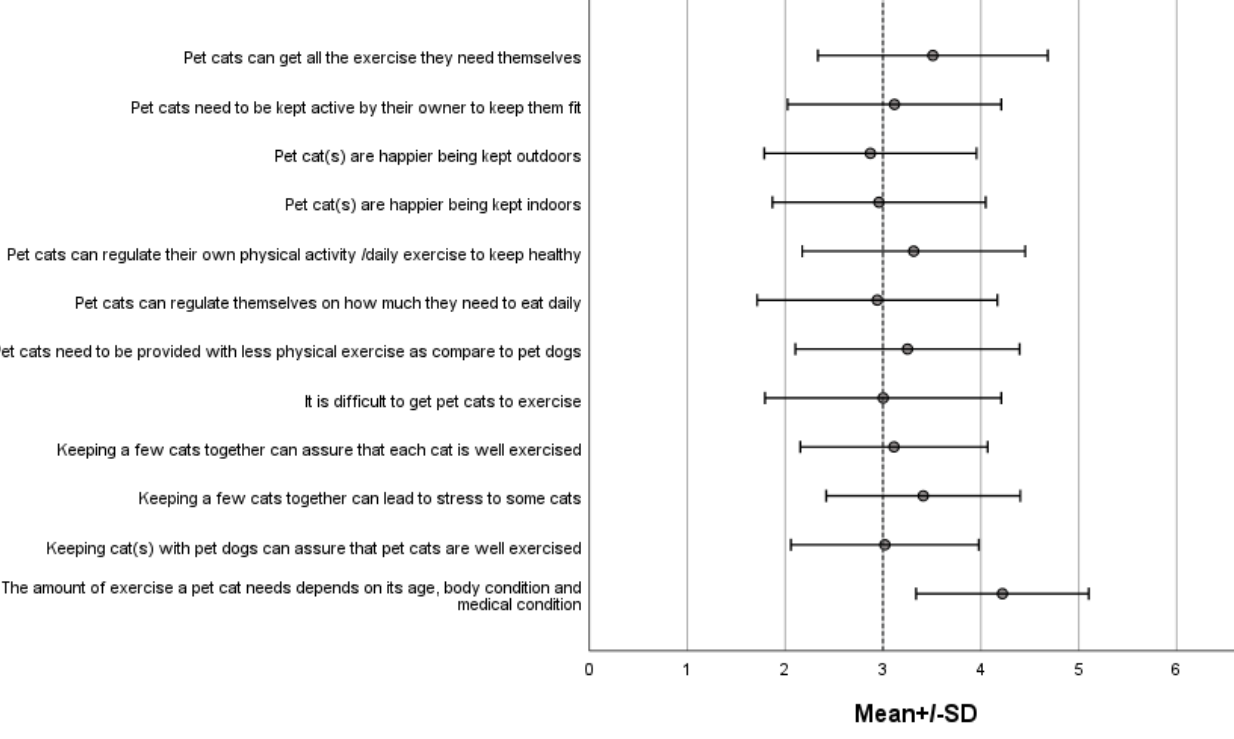
Figure 2. Owners perception of their cats needs and satisfaction. Response options ranged from 1 (“Strongly Disagree”) to 5 (“Strongly Agree”). The midline at Likert score = 3 represents a neutral view (answers “Neutral” and “Not sure”).